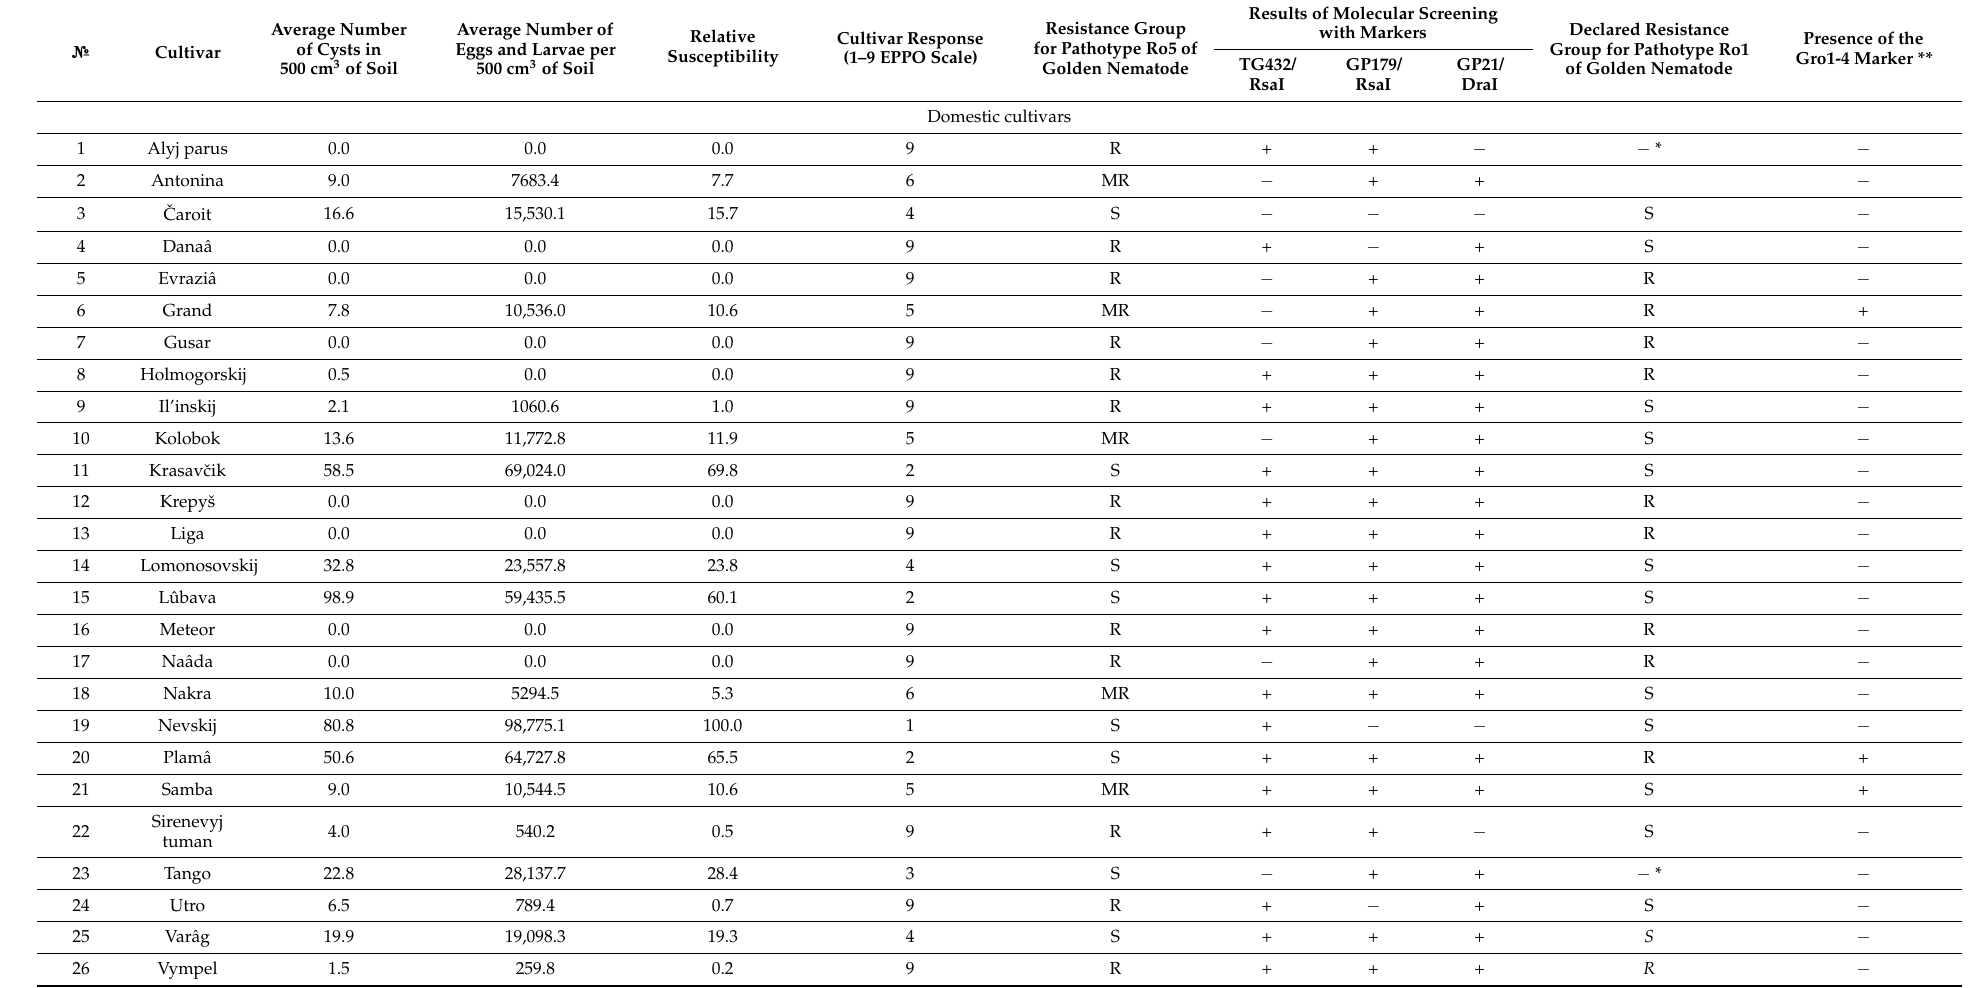
Table 4. Resistance of potato cultivars to G. rostochiensis pathotype Ro5 and data of molecular marker analysis with three markers of the Grp1_QTL. Resistance group: R—resistant, MR—moderately resistant, S—susceptible. “+”—fragment presents, “ − ”—fragment absents. № Cultivar